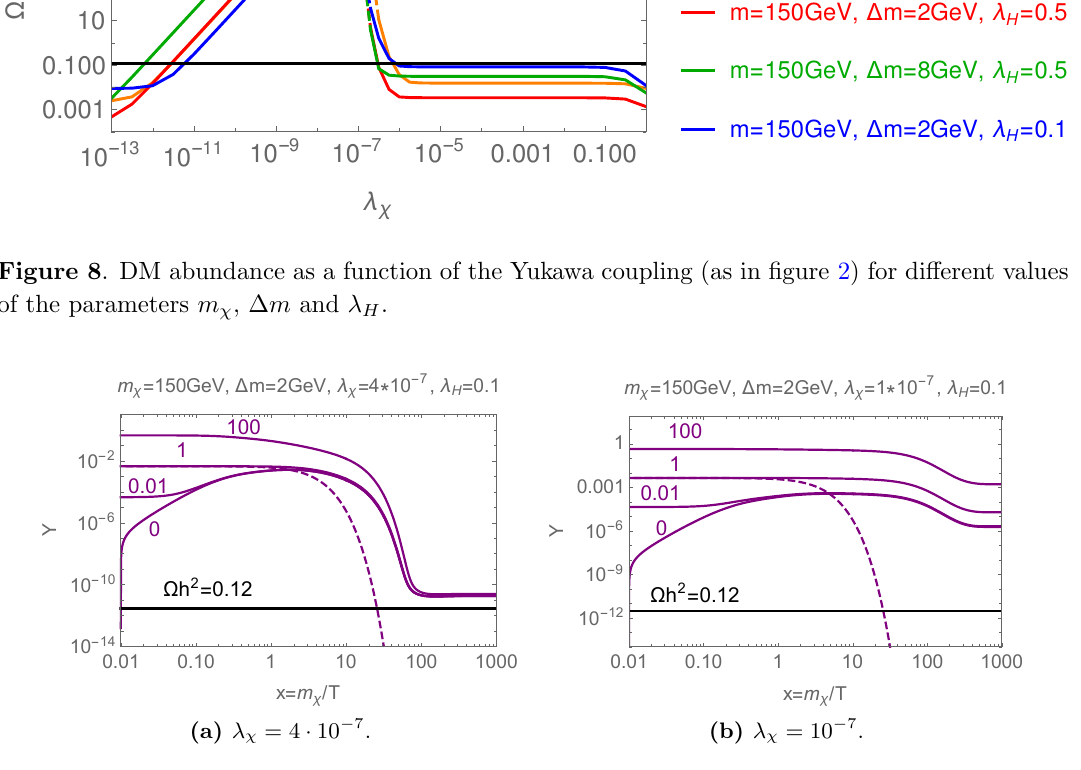
[1] eq (cid:22) as the co-annihilation partner and e , (cid:1) m , and (cid:21) (cid:31) H